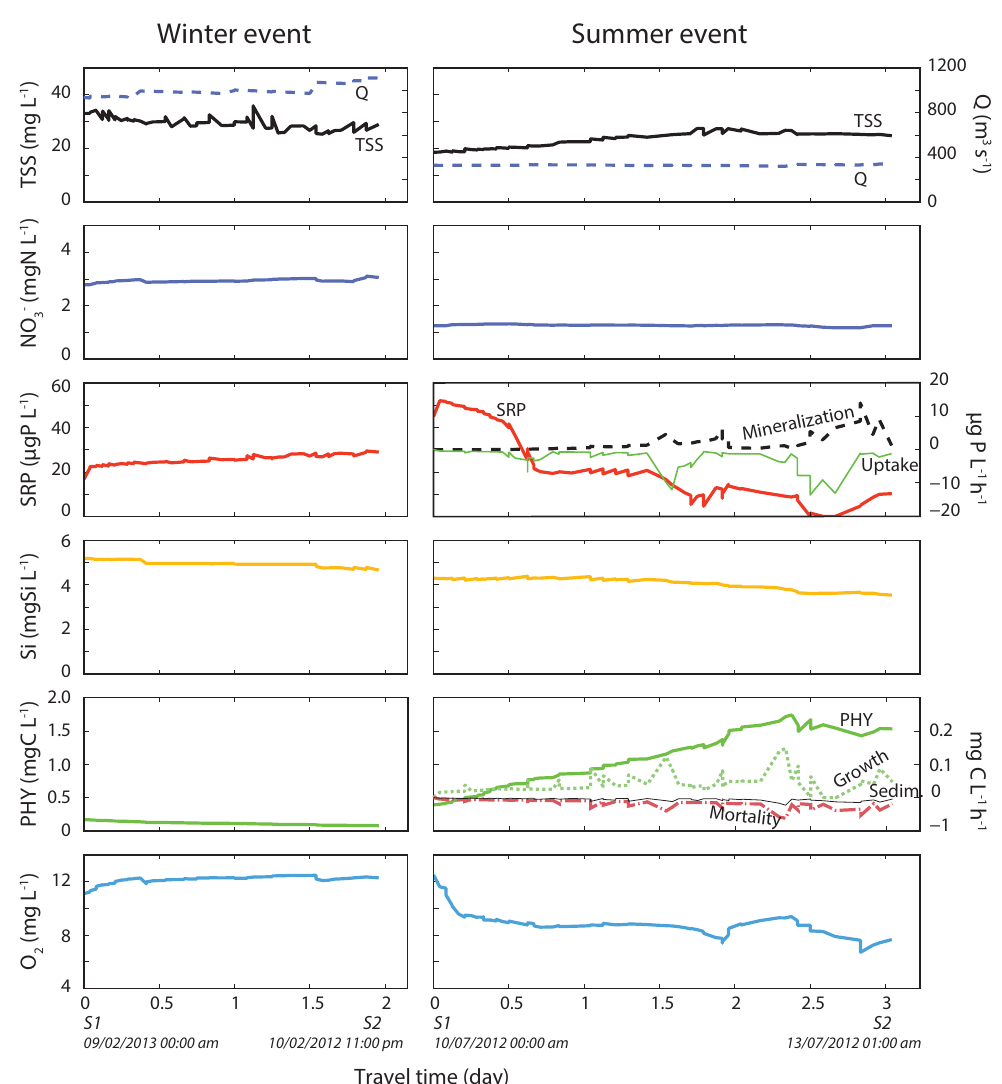
Figure 5. Lagrangian profiles from S1 to S2 of TSS, NO − , SRP, Si, PHY and O 2 during two selected events. For the summer event, P input 3 from mineralization processes, P uptake from phytoplankton, phytoplankton growth rate (availability of intracellular carbon and nutrients), sedimentation and mortality rates are also displayed on the right